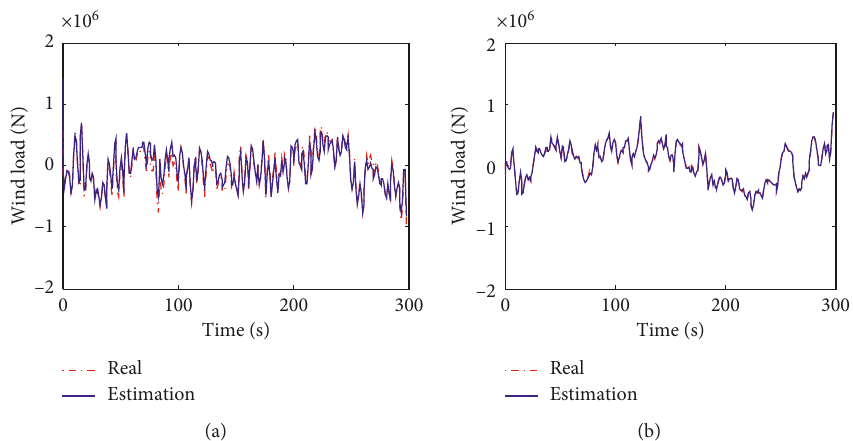
Figure 17: Comparison of the equivalent wind load time histories in direction X under wind direction of 180 ° on the (a) 24th floor and (b) 58th